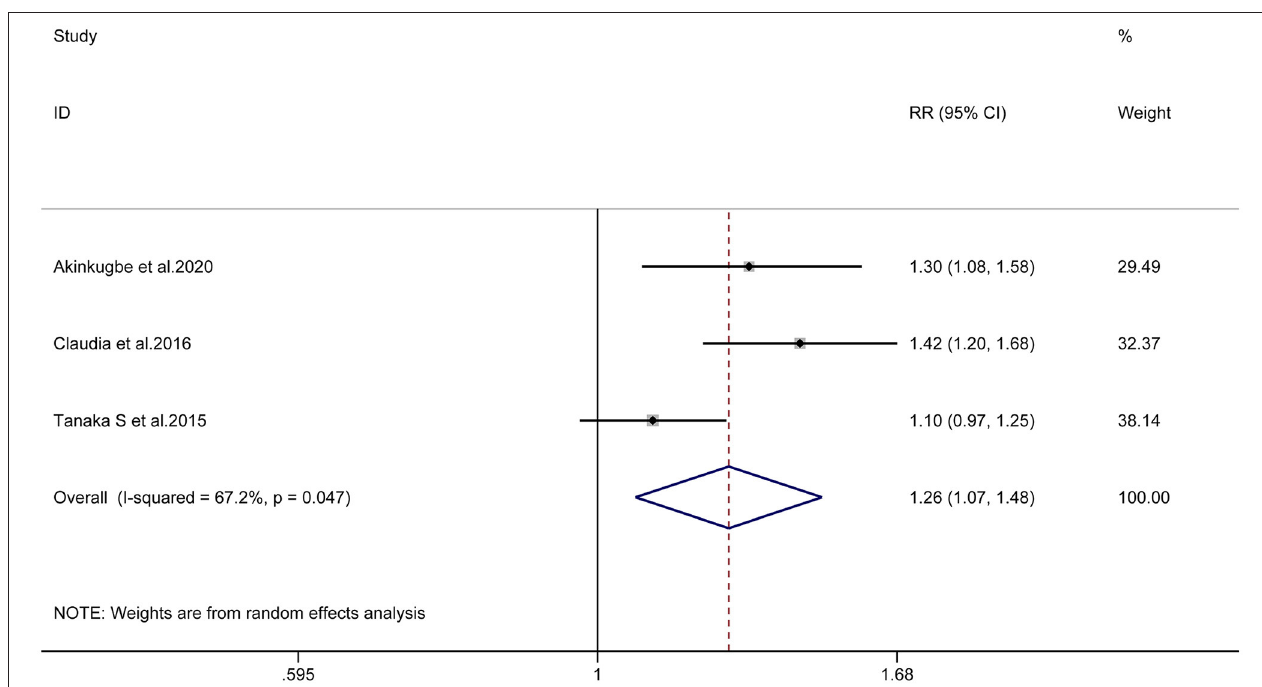
FIGURE 3 | Funnel plot of the included cross-sectional studies on the association between prenatal smoking and dental caries in children.